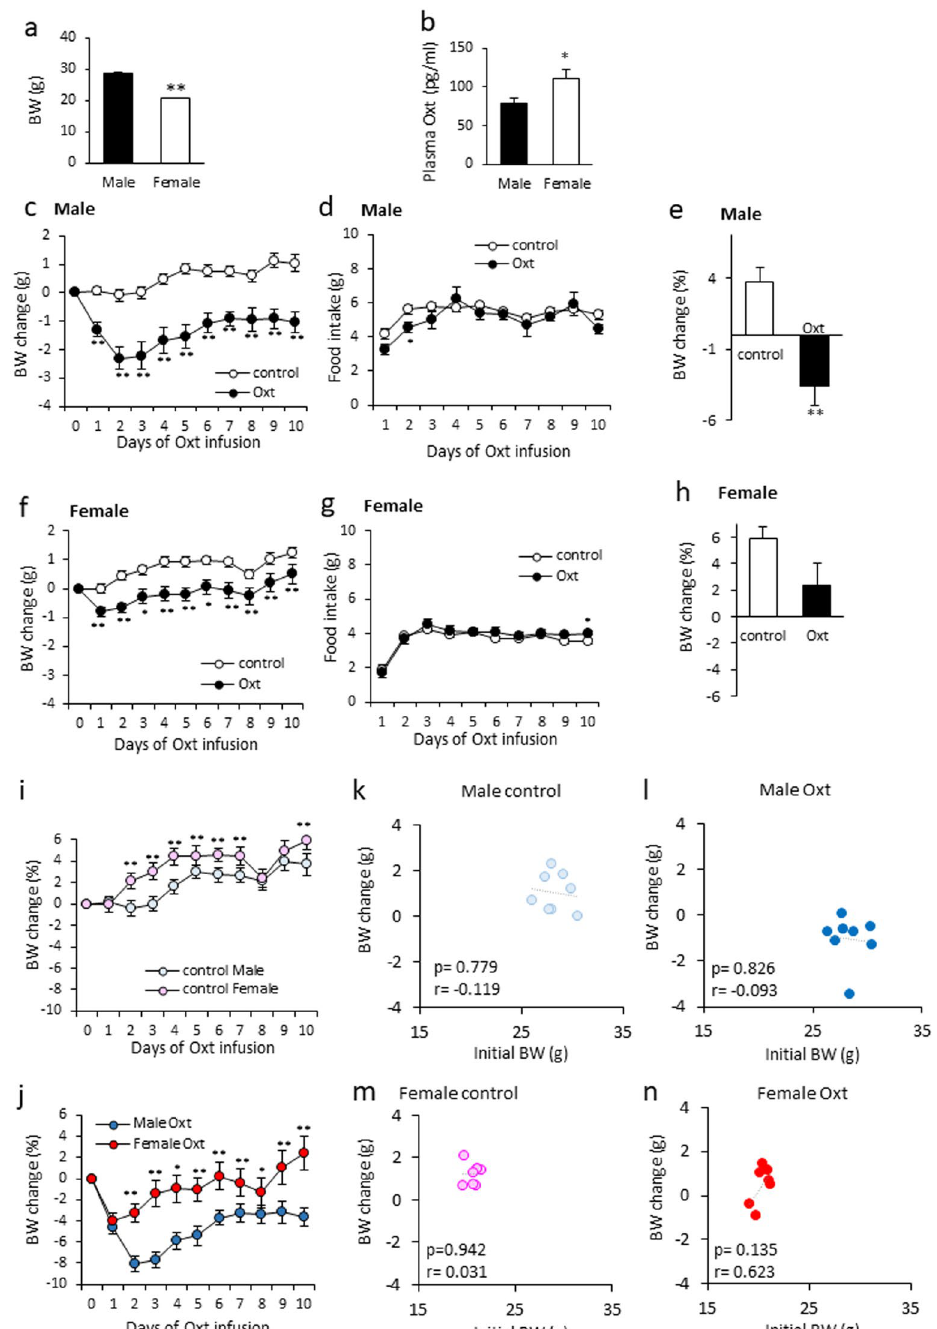
Figure 3. The effect of Oxt treatment on BW and food intake in male and female mice fed a standard-chow diet. ( a ) Initial body weight of males and females used in this study. ( b ) Plasma Oxt levels in standard chow-fed male and female mice (n = 10 each). ( c , d ) Daily change of BW change ( c ) and food intake ( d ) during the infusion period in standard chow-fed male mice. (n = 8 each). ( e ) The percentage of BW change at 10 days after starting Oxt infusion in male mice. ** P < 0.01 by unpaired Student’s t -test. ( f , g) Daily change of BW change ( f ) and food intake ( g ) during the infusion period in standard chow-fed female mice. (n = 7, 8) * P < 0.05, ** P < 0.01 by two- way ANOVA followed by Tukey’s multiple range test. ( h ) The percentage of BW change at 10 days after starting Oxt infusion in male mice. P = 0.068 by unpaired Student’s t -test. ( i ) The percentage of BW change during 10 days in control male and female. ** P < 0.01 by two-way ANOVA followed by Tukey’s multiple range test. ( j ) The percentage of BW change during 10 days in Oxt treated male and female. * P < 0.05, ** P < 0.01 by two-way ANOVA followed by Tukey’s multiple range test. ( k , l ) The correlation of BW change at 10 days and initial BW (BW at day0) in the control ( k ) and Oxt-treated ( l ) male mice. ( m , n ) The correlation of BW change at 10 days and initial BW (BW at day0) in the control ( m ) and Oxt-treated ( n ) female